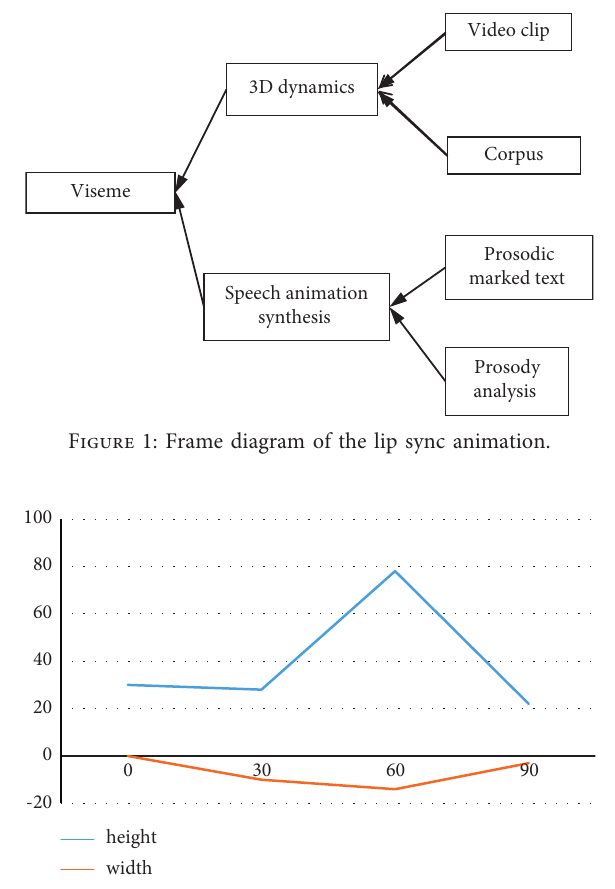
Figure 2: Pronunciation characteristic